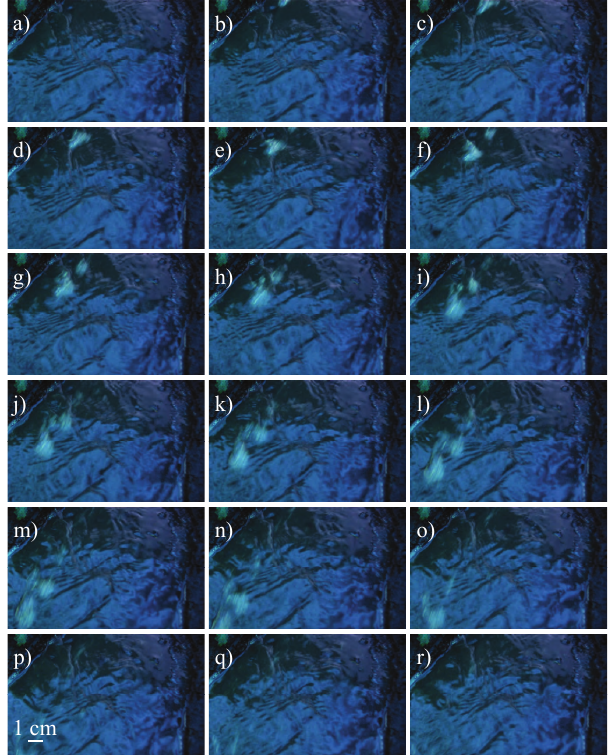
Fig.6. Sequenceofsnapshotsdepictingthetransitofacloudofparticlesflowingintherillbelowthedetectionapparatus. Thediameterof thebeadslaysintherange 75 (cid:0) 90 (cid:22) m . Fig. 6. Sequence of snapshots depicting the transit of a cloud of par- ticles flowing in the rill below the detection apparatus. The diameter of the beads lays in the range